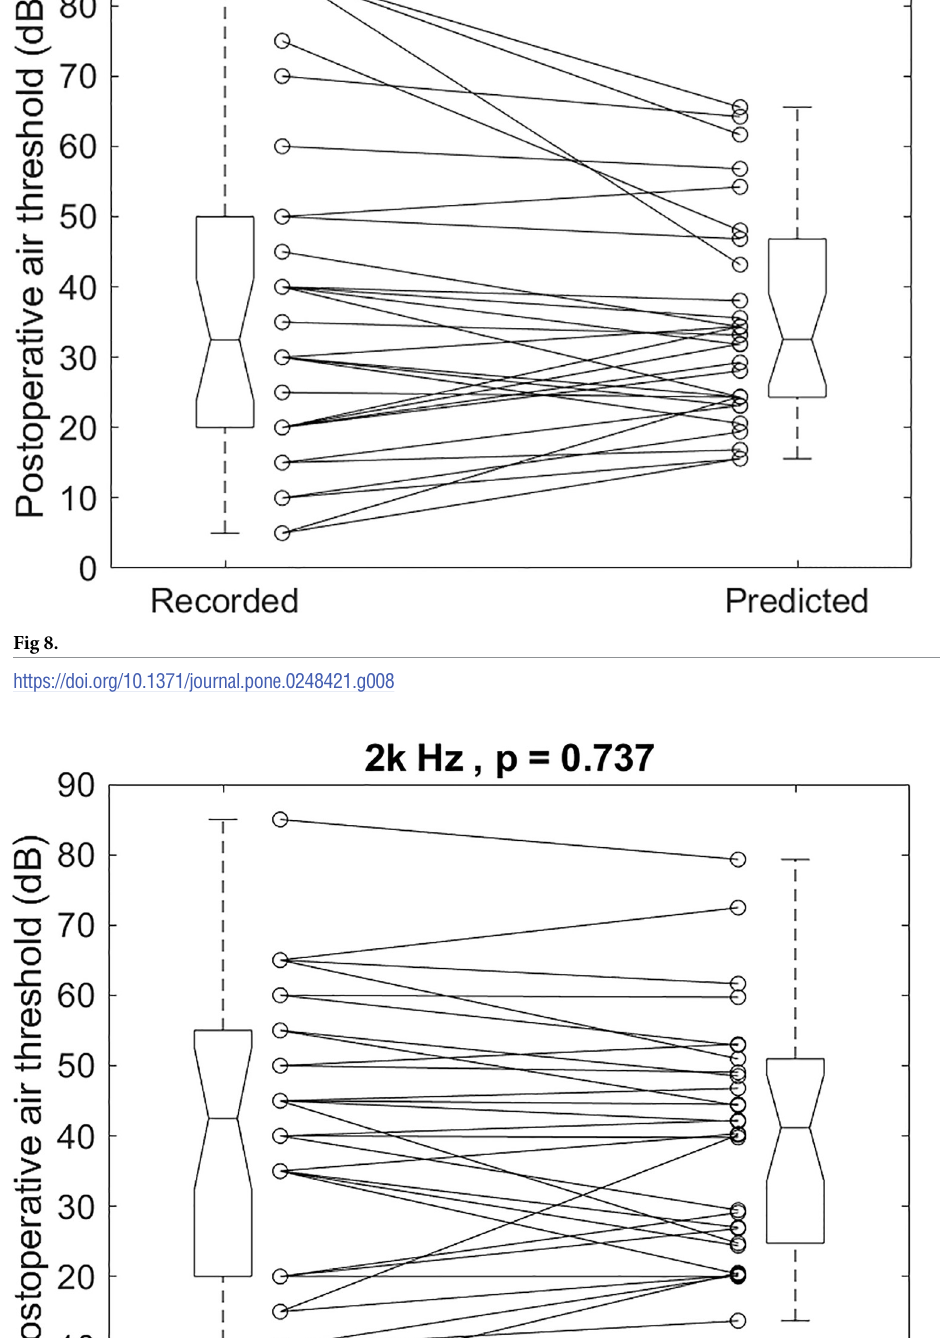
PLOS ONE | https://doi.org/10.1371/journal.pone.0248421 March 11,